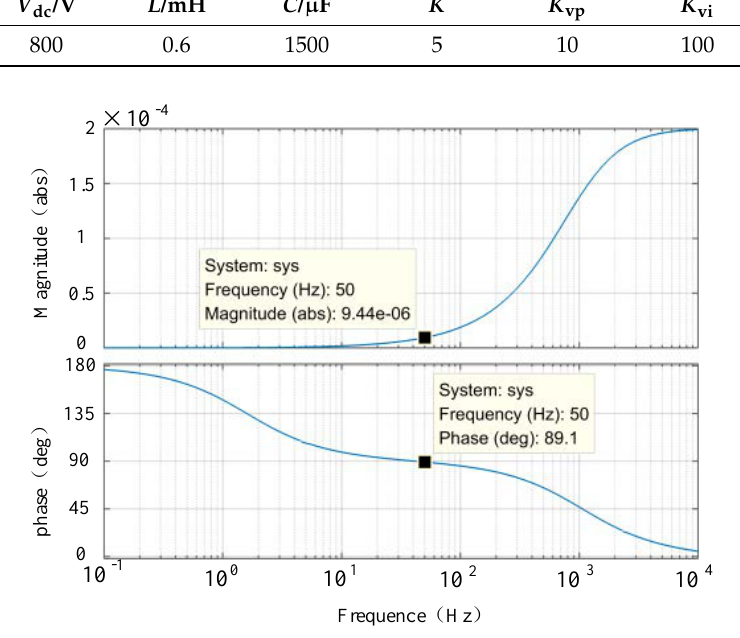
Figure 2. Bode diagram of the output impendence.